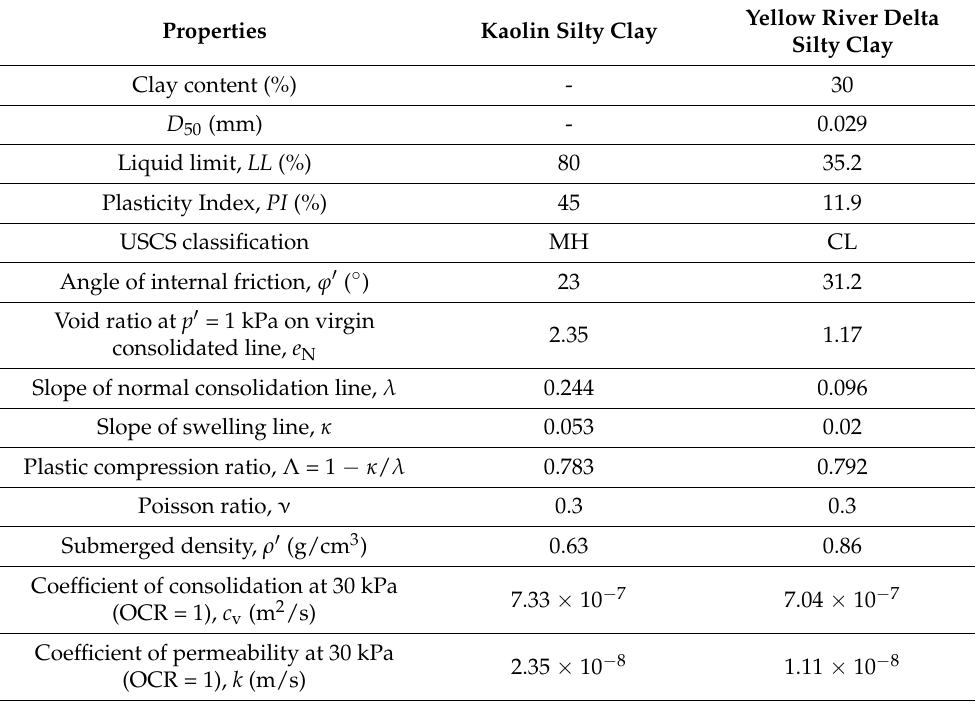
Table 1. MCC model parameters of the kaolin silty clay [25] and the Yellow River silty clay